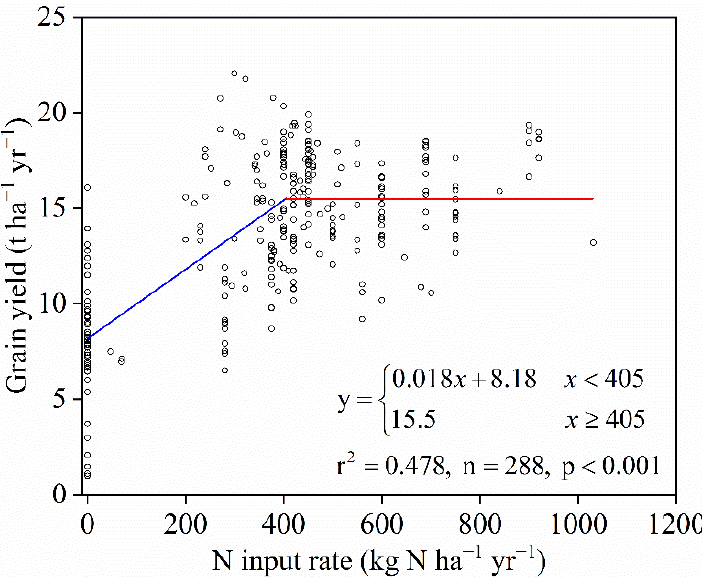
Figure 1. Relationship of grain yields (t ha − 1 yr − 1 ) against N input rates (kg N ha − 1 yr − 1 ) in winter wheat–summer maize rotation.